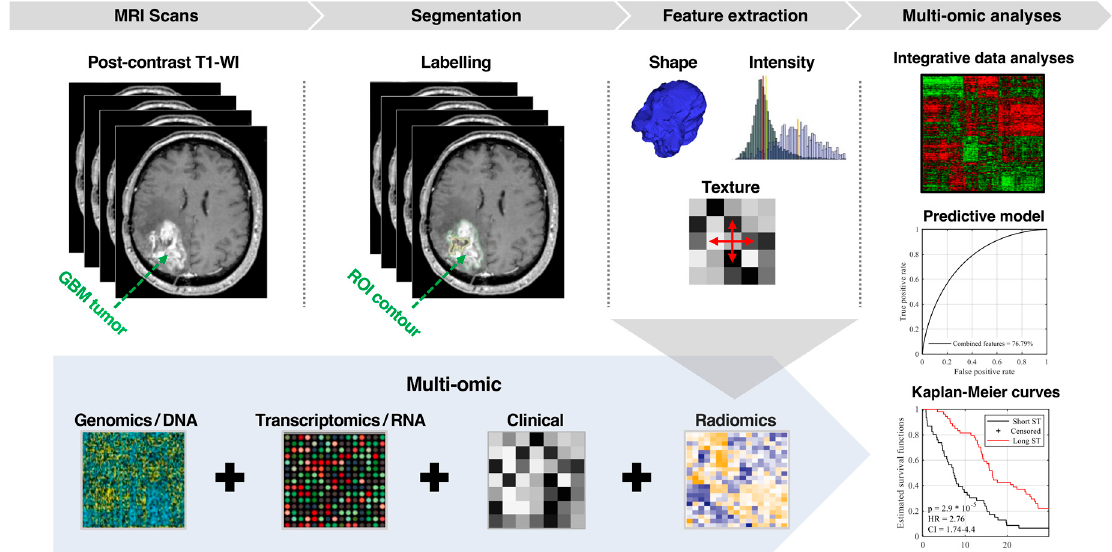
Figure 4. Schema of the proposed pipeline for predicting the survival outcome of GBM IDH1 wild type. ( 1 ) Post-contrast T1-WI MR images of 200 patients with GBM (i.e., 71 + 129 patients from TCGA/TCIA and MUHC), ( 2 ) identification of regions of interest (ROI) and labelling, ( 3 ) high-throughput radiomics features related to geometric / shape, intensity volume histogram that represents the